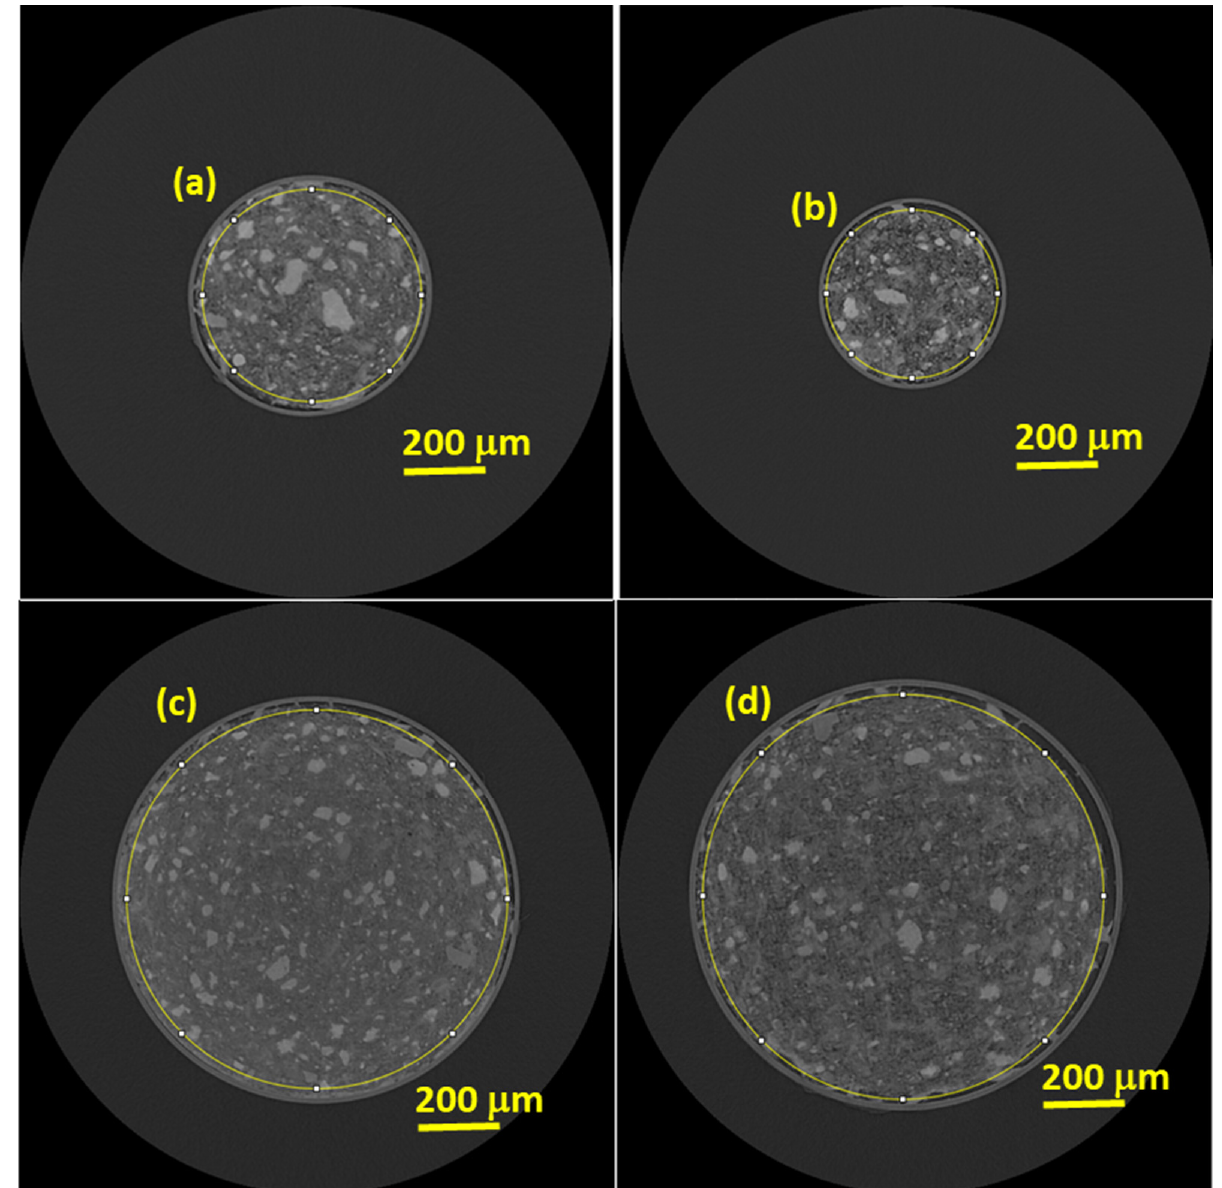
Figure 4. Selected reconstructed tomographic orthoslices for the studied pastes. ( a ) w/c = 0.45 paste within a capillary of nominal diameter of 0.5 mm. ( b ) w/c = 0.65 paste in a φ = 0.5 mm capillary. ( c ) w/c = 0.45 paste in a φ = 1.0 mm capillary. ( d ) w/c = 0.65 paste in a φ = 1.0 mm capillary. The sizes of the capillaries measured with a calibre, in the same sequence, were: 0.55, 0.45, 1.01 and 1.06